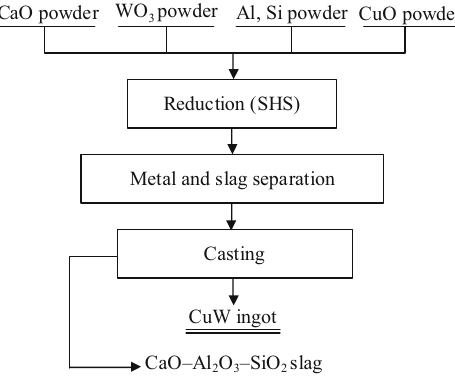
Figure 1: The fl owchart of synthesizing the CuW composite via the aluminothermic coupling with silicothermic